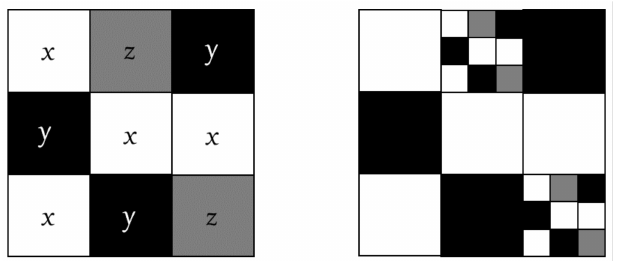
Figure 4. Pore solid fractal model. The black part is solid, the white part is pore and the gray part is the iterative